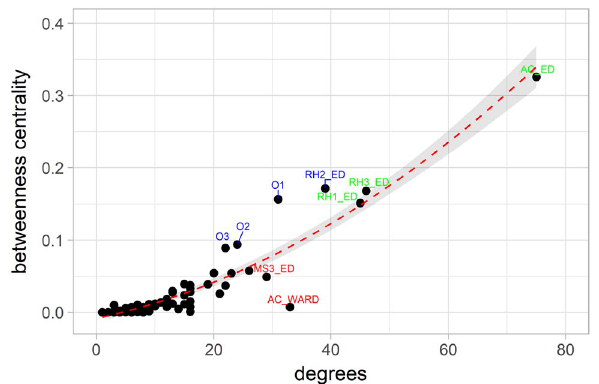
Figure 3. Relation of betweenness centrality and degree. The expected squared correlation is clearly visible with a few outliers. RH2_ED, O1, O2 and O3 (blue) show higher betweenness centrality than expected by their degree connectivity. These nodes, in particular RH2_ED (as a hospital location) are important for the integrity of the network. The other outliers, AC_WARD and MS3_ED (red), have betweenness centrality lower than expected. In green we show the major hubs of the network, AC_ED, RH1_ED and RH3_ED.